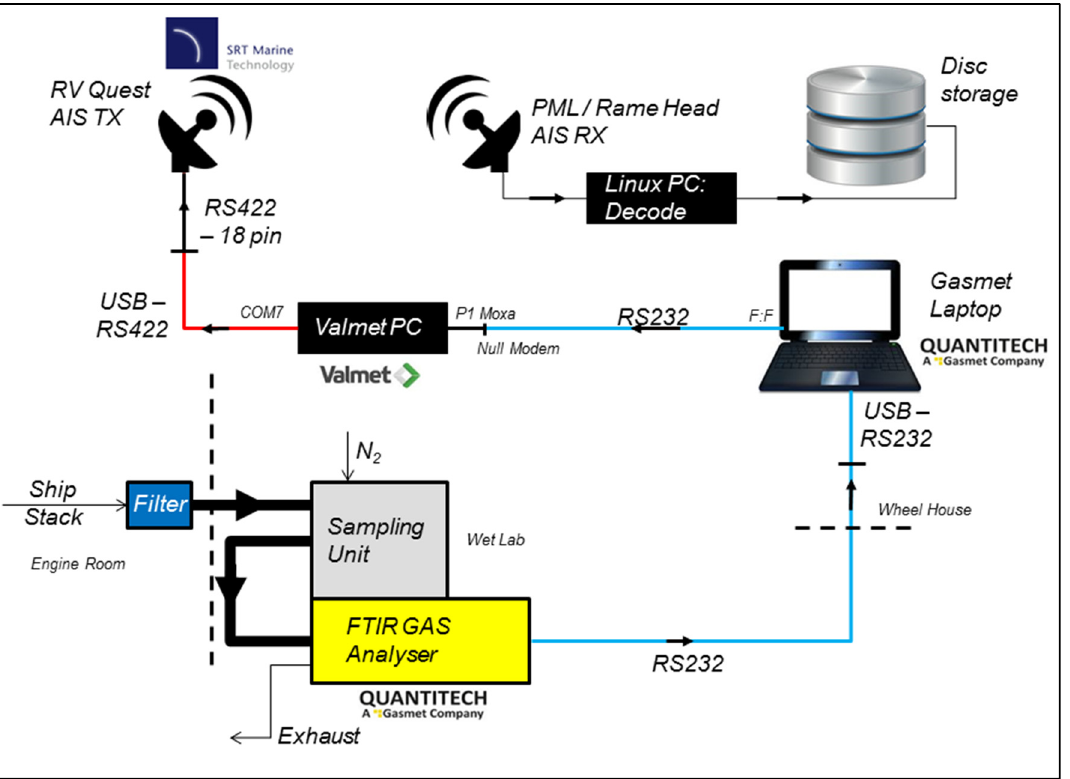
Table 1. Concepts proved and themes demonstrated on Trial 1 .